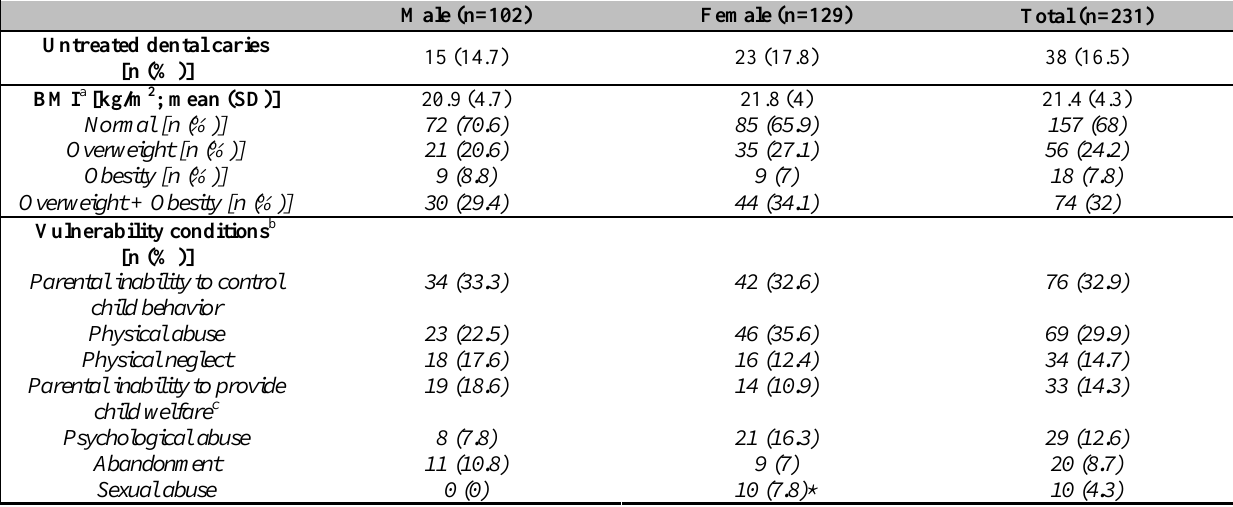
Table 2. Prevalence of untreated dental caries, overweight/obesity, and vulnerability conditions in 231 Latin American children in the child protection system of Aragon (Spain)